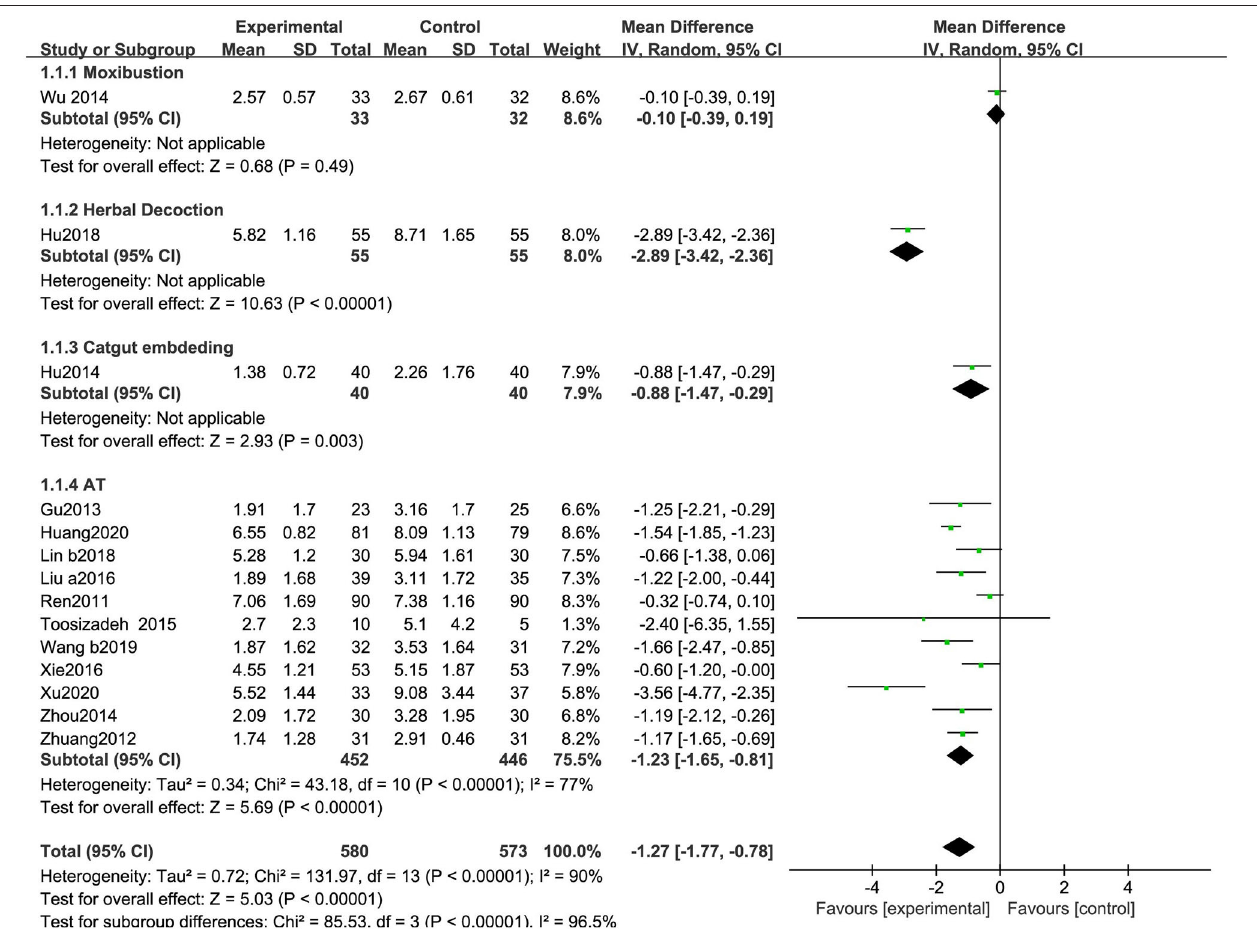
FIGURE 7 | Comparison of acupuncture related therapies in terms of